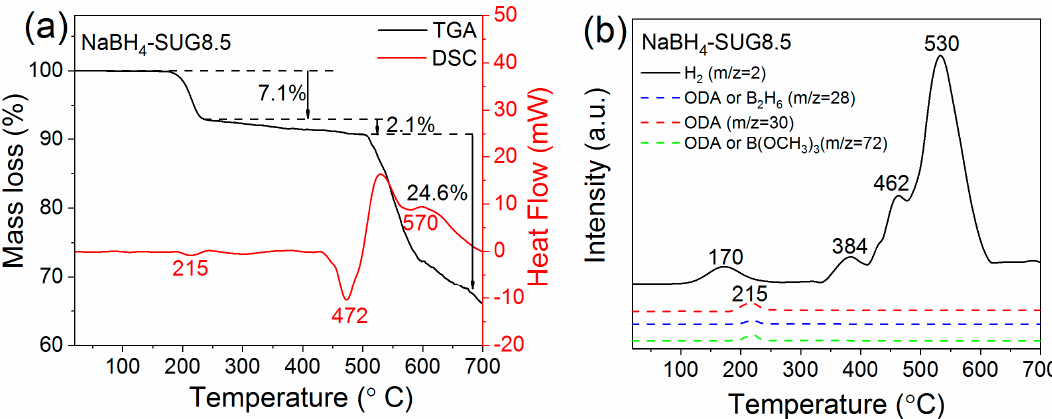
Figure 8. ( a ) TGA/DSC under Ar of NaBH 4 -SUG8.5; ( b ) H 2 desorption from NaBH 4 -SUG8.5 recorded by mass spectrometry and selected mass corresponding to the release of B 2 H 6 , B(OCH 3 ) 3 , and